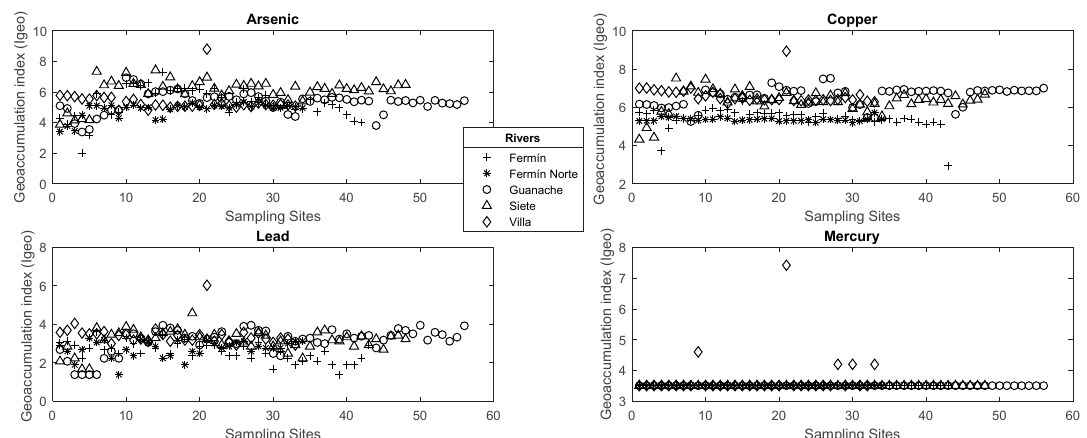
Figure 5. Downstream longitudinal sequence plots of Igeo for As, Cu, Pb and Hg.